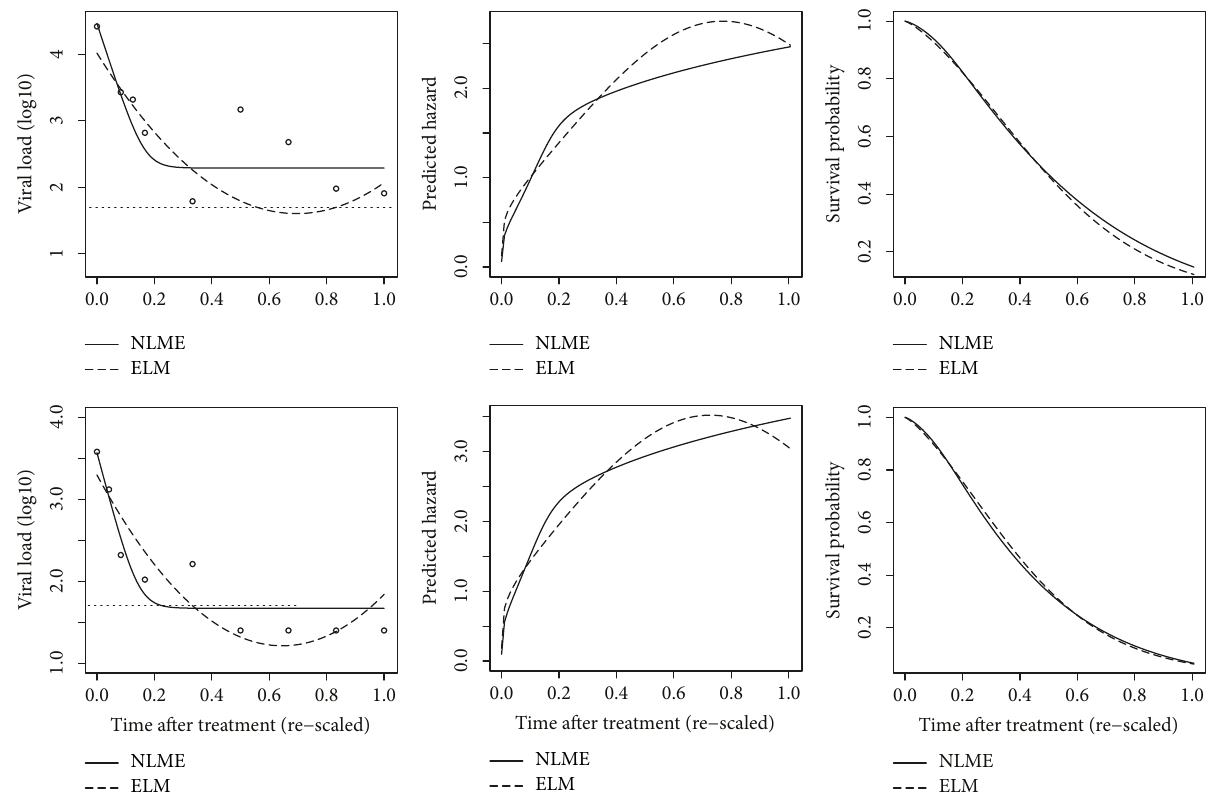
Figure 2: Plot of two individuals' (first row and 2nd row) fitted (predicted) viral load values and the corresponding hazard, survival functions based on the joint Cox and NLME model and empirical LME model (ELM), respectively. The open circles represent the observed viral loads. Left censored viral loads are replaced by one-half of the detection limit (in log 10 -scale). Table 2: Parameter estimates in the Cox model based on the NLME and ELM covariate models respectively. Cox model